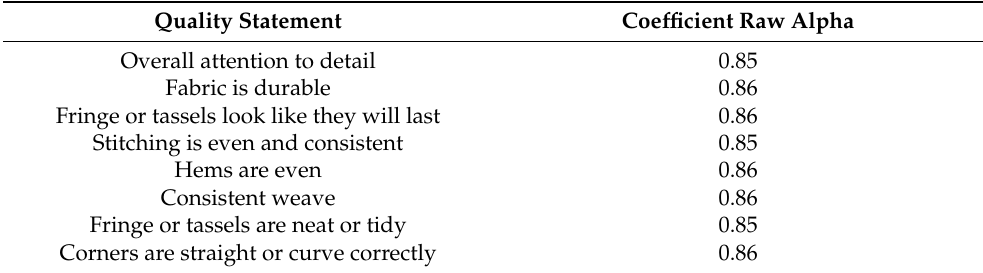
Table 7. Reliability of quality statements remaining in the scale (overall coefficient α = 0.87).